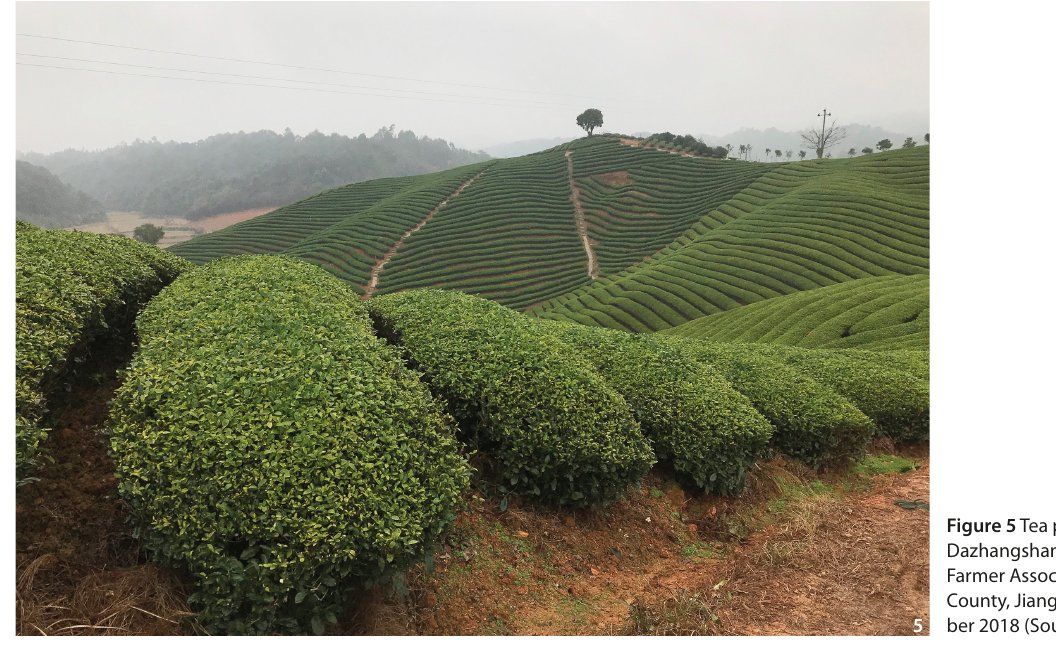
Figure 5 Tea plantation of the Dazhangshan Organic Tea Farmer Association, Wuyuan County, Jiangxi Province, Decem- ber 2018 (Source: the author).